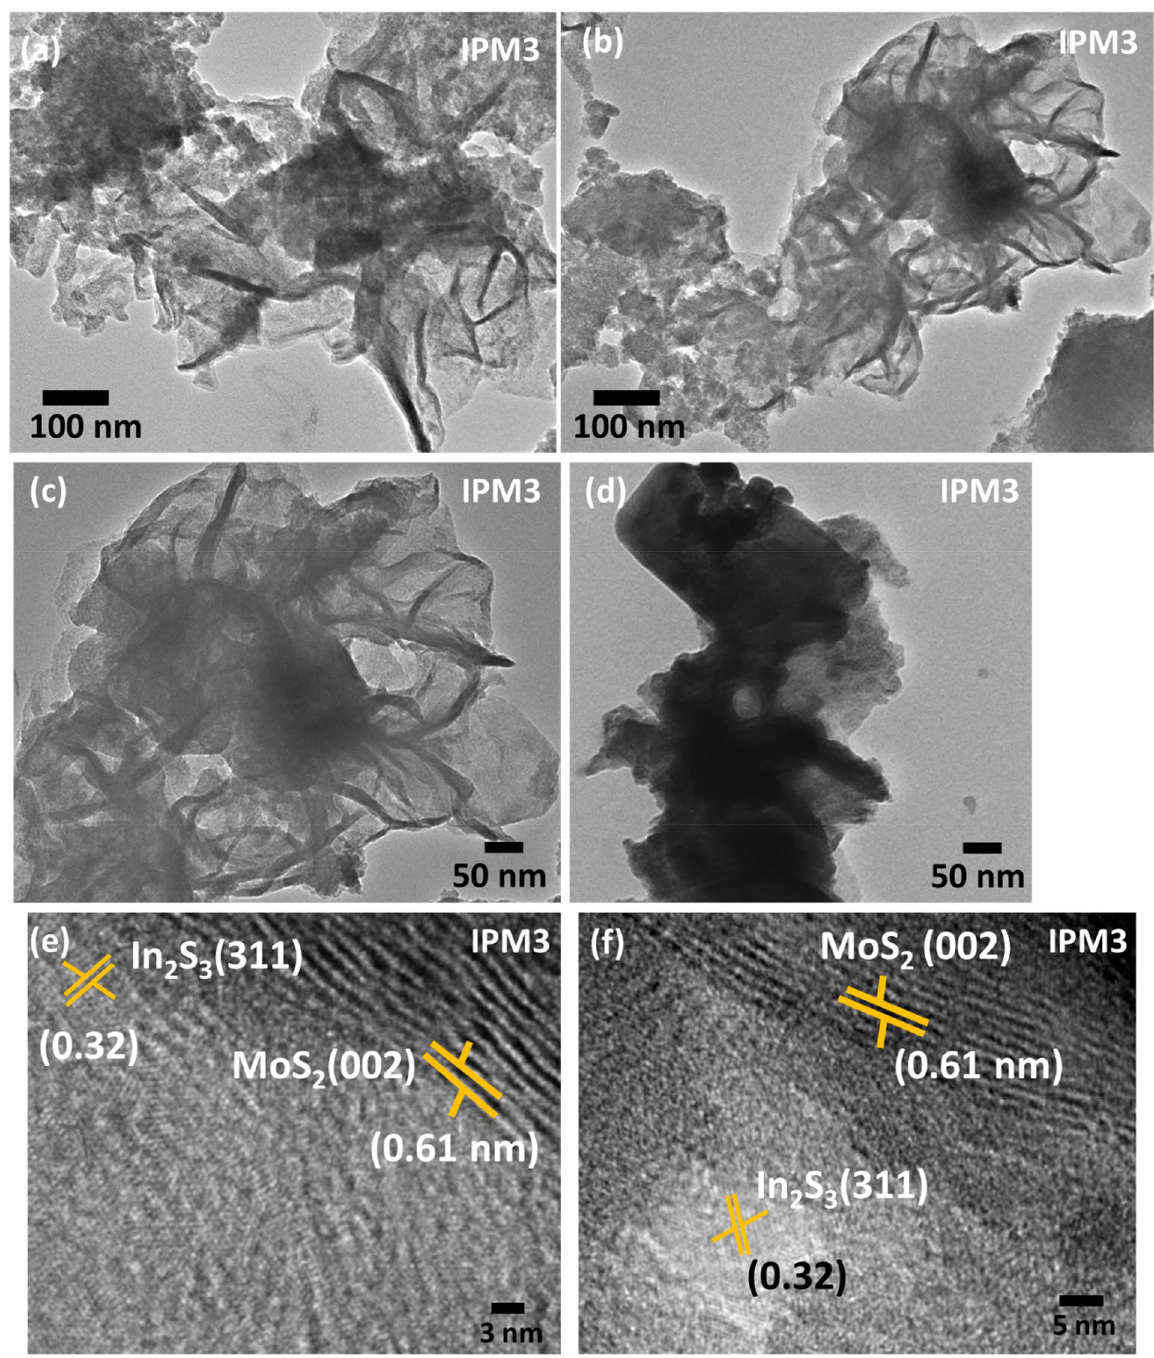
Figure 5. ( a – d ) TEM image of sample IPM3 revealing the formation of In 2 S 3 nanosheet decorated MoS 2 nanoflowers, ( e , f ) High-resolution TEM images indicating fringes distance for MoS 2 and In 2 S